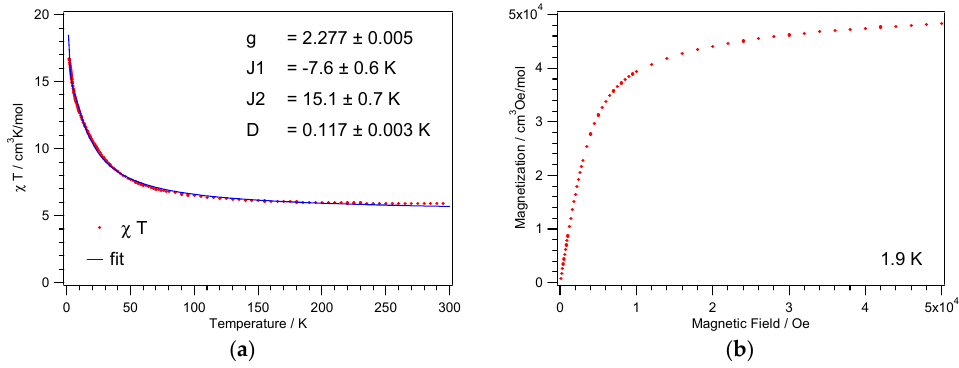
Figure 5. Temperature dependence of the χ M T product ( a ) and magnetization vs. field ( b ) for 1 .